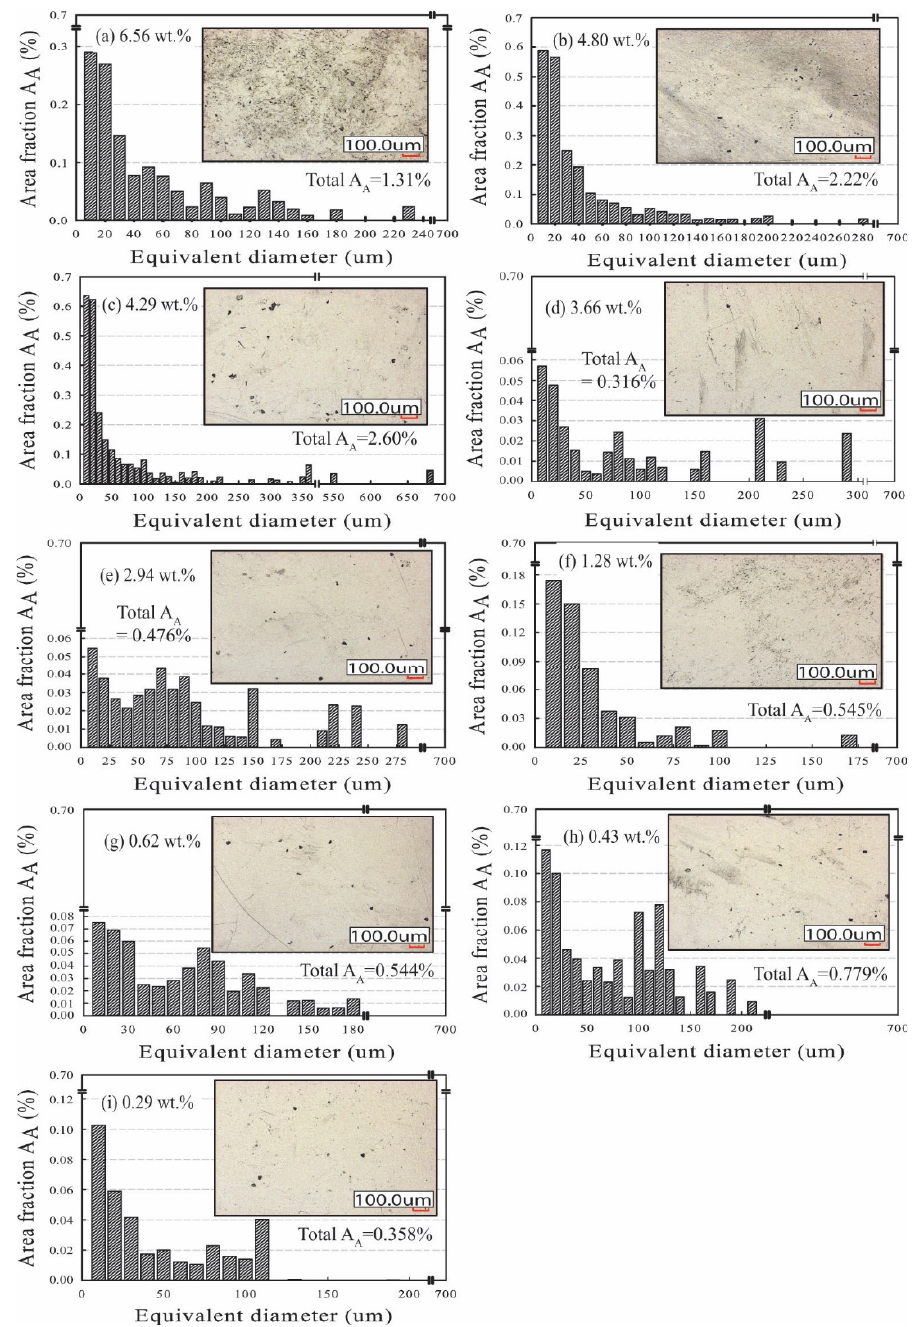
Figure 5. Size distribution of undispersed SWNT agglomerates observed in composites; SWNT content and total agglomerate area ( A A ) are described in each figure. ( a ) 6.56 wt.%; ( b ) 4.80 wt.%; ( c ) 4.29 wt.%; ( d ) 3.66 wt.%; ( e ) 2.94 wt.%; ( f ) 1.28 wt.%; ( g ) 0.62 wt.%; ( h ) 0.43 wt.%; ( i ) 0.29 wt.% .